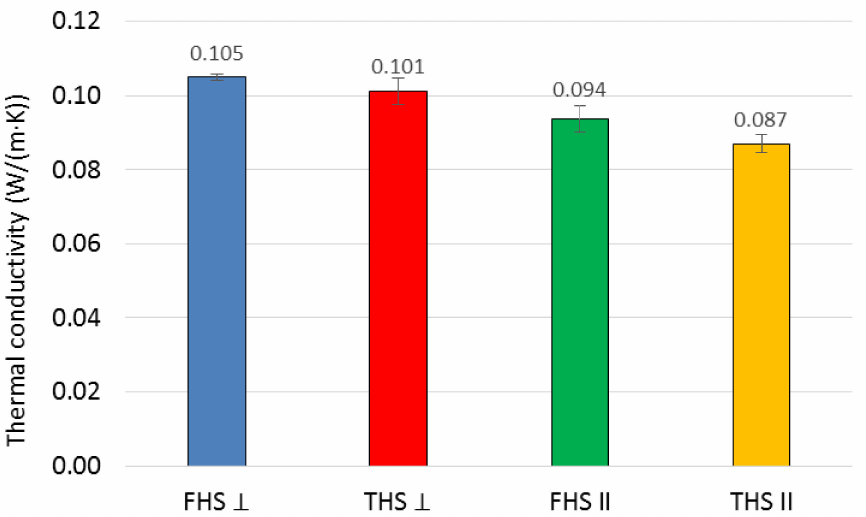
Figure 7. Results of the thermal conductivity